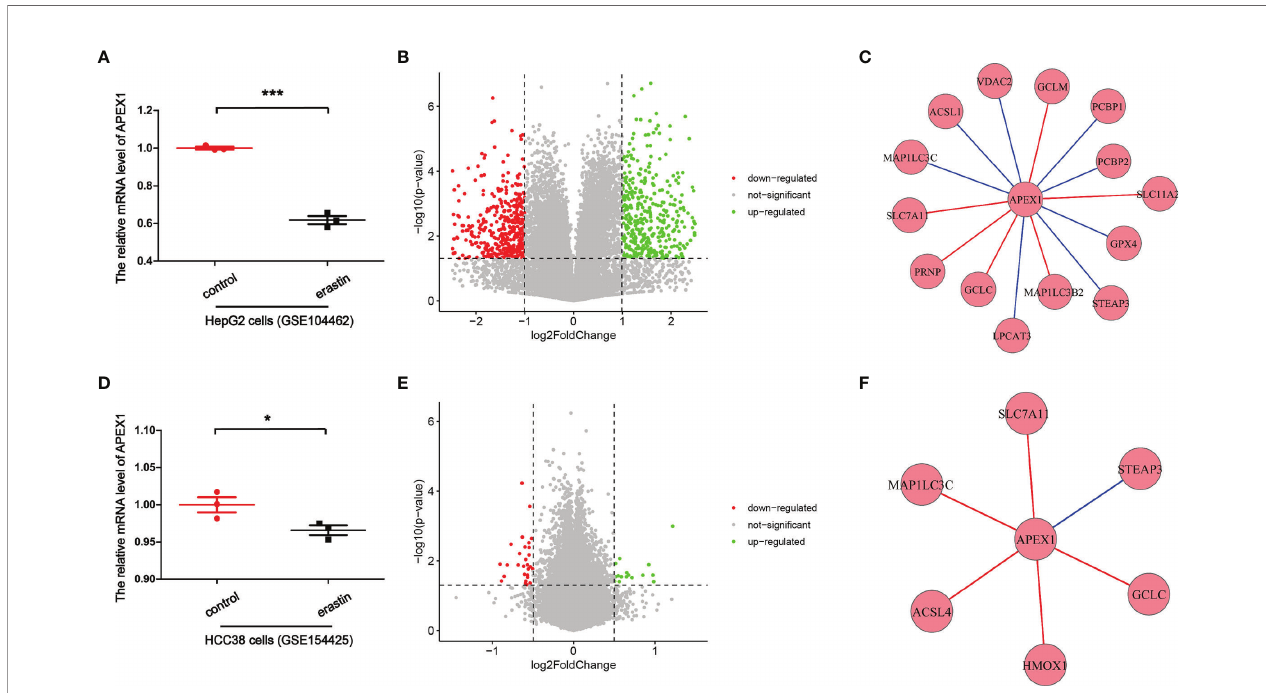
FIGURE 4 | Bioinformatics analysis for APEX1 transcriptional expression. (A) The relative mRNA level of APEX1 in HepG2 cells. (GSE104462) (***P < 0.001, n = 3). (B) Volcano plot showed signi fi cantly differentially expressed genes. (GSE104462). (C) APEX1 correlated with genes in the ferroptosis pathway. (GSE104462). (D) The relative mRNA level of APEX1 in HCC38 cells. (GSE154425) (*P < 0.05, n = 3). (E) Volcano plot showed signi fi cantly differentially expressed genes. (GSE154425). (F) APEX1 correlated with genes in the ferroptosis pathway.